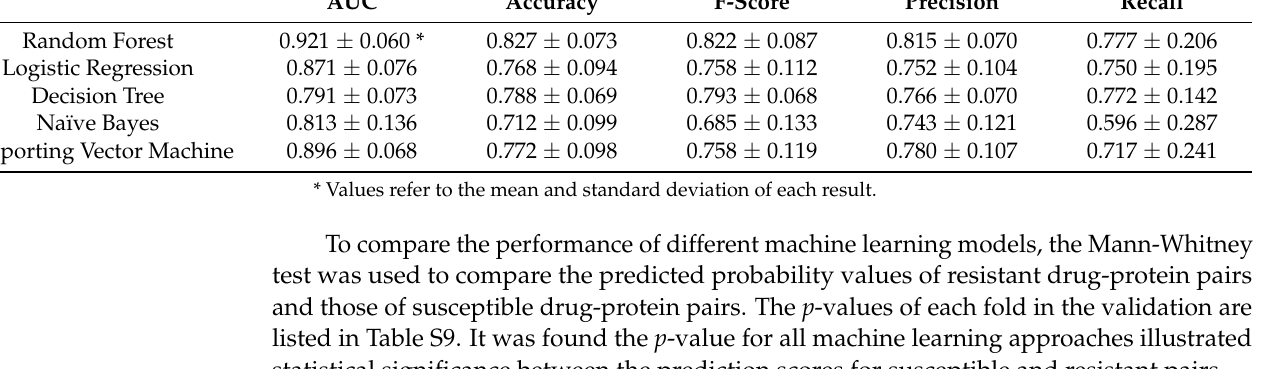
Table 1. The model performance of 10-fold cross-validation using different machine learning ap- proaches on training dataset.